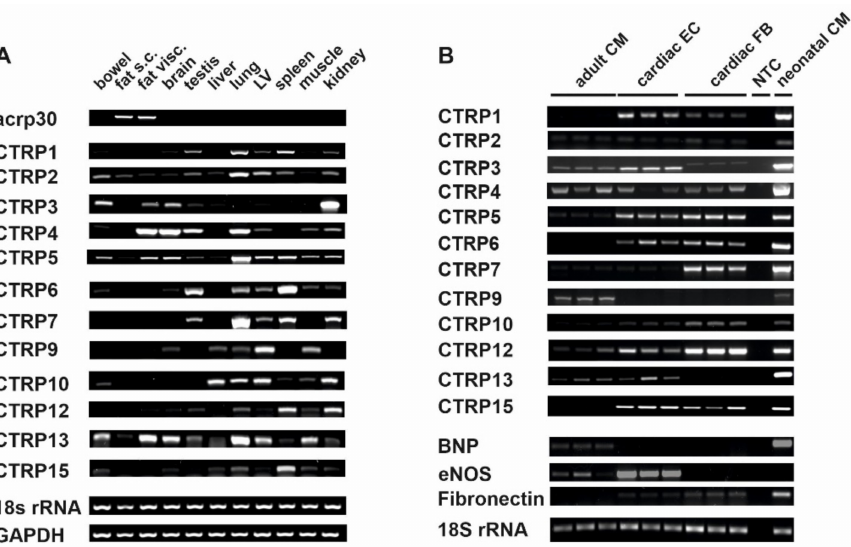
Figure 1. Analysis of the expressional pattern of the currently known C1q/tumor necrosis factor- alpha-related protein (CTRP) mRNAs by conventional RT-PCR in rats. CTRP expression in ( A ) vari- ous rat tissues and ( B ) different cardiac